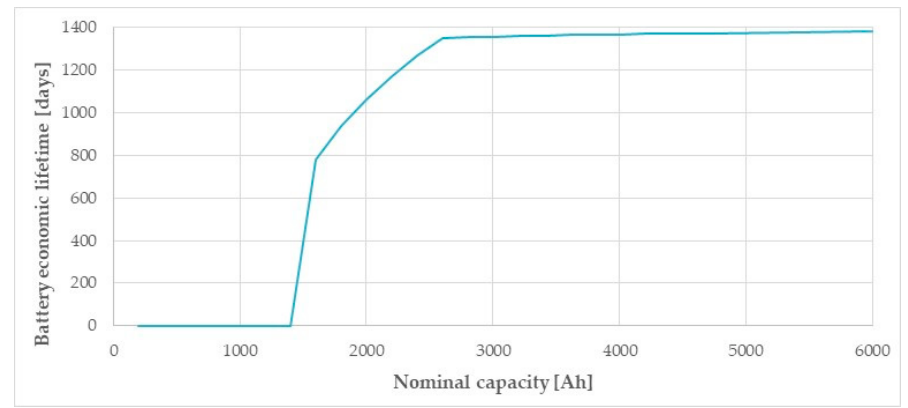
Figure 11. Battery economic lifetime for the SAPV system with respect to the capacity of the 108 V AGM VRLA battery system while the PV population is 120.